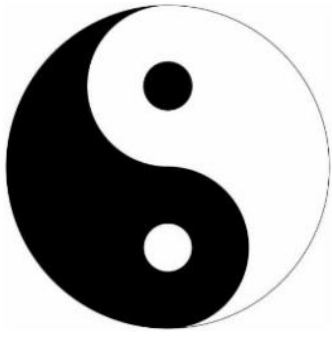
Figure 1. Yin and Yang.